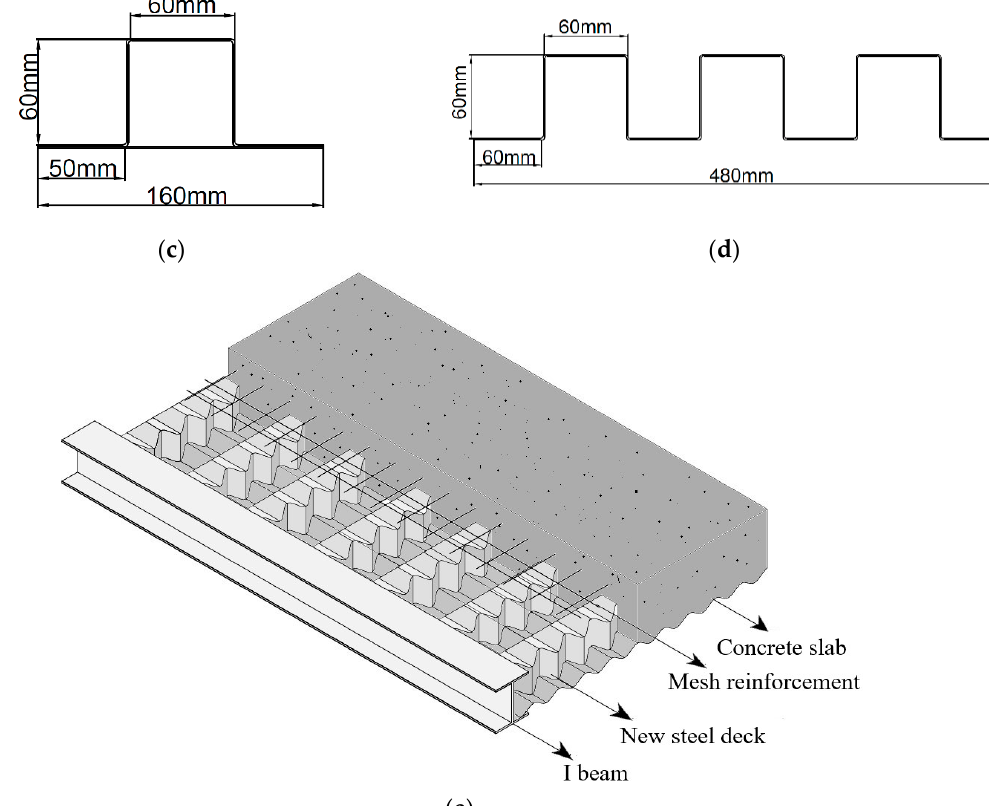
Figure 5. Details of the proposed innovative profiles: ( a ) proposed top-hat section; ( b ) proposed multiple hat sections; ( c ) cross-section properties of top-hat section geometry; ( d ) cross-section properties of multiple hat section geometry; and ( e ) the possible application of the proposed deck in composite slim-flooring.